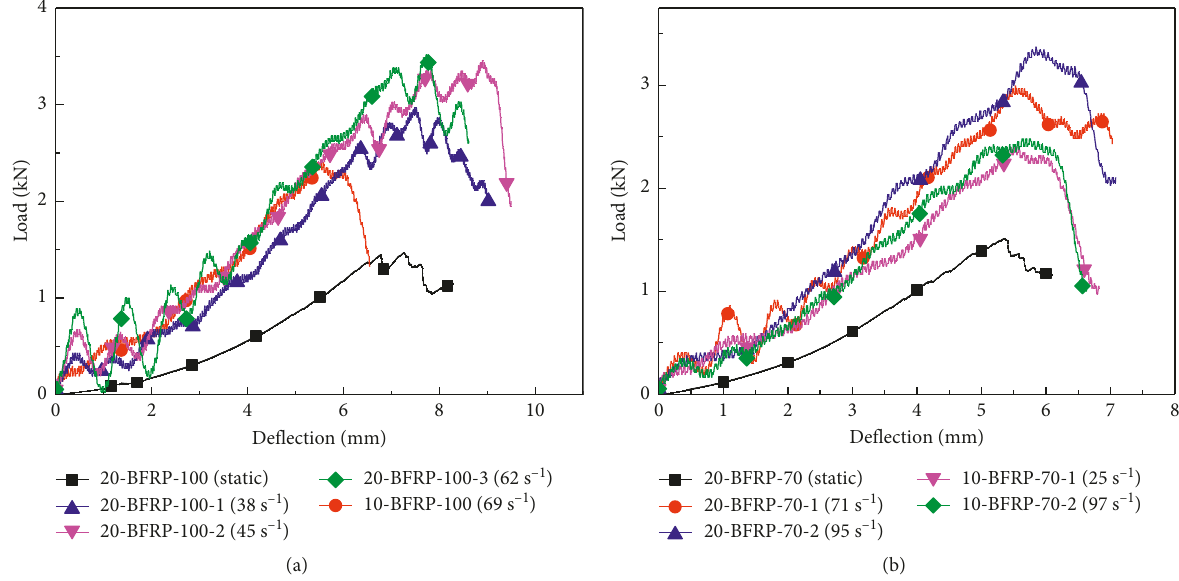
Figure 3: Load-deflection curves of the BFRP plate under drop-weight impact: (a) 100mm specimen and (b) 70 mm specimen.